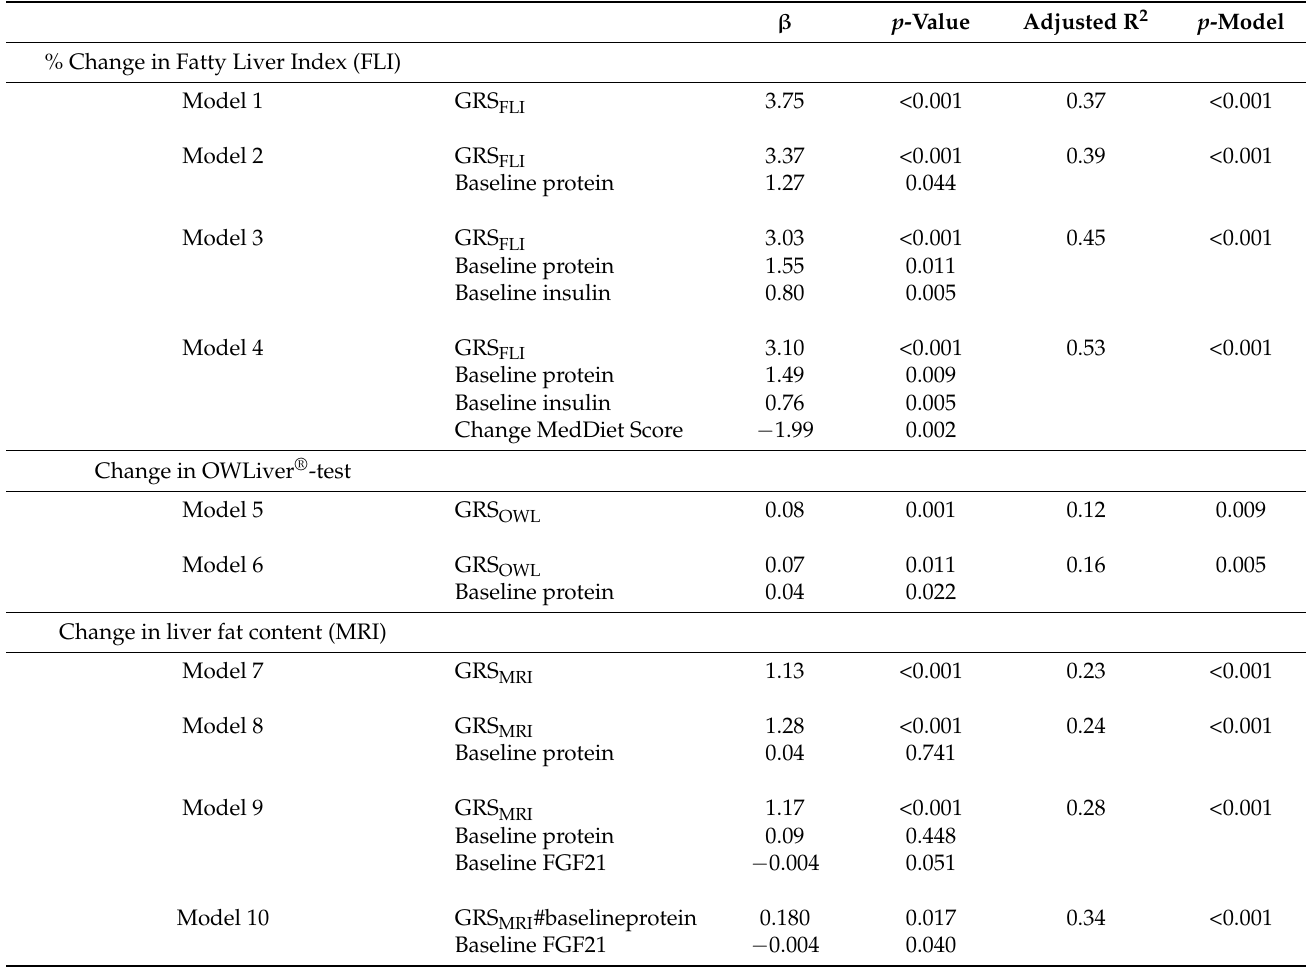
Table 3. Linear regression analyses of changes in fatty liver index, OWLiver ® -test and liver fat content (MRI).